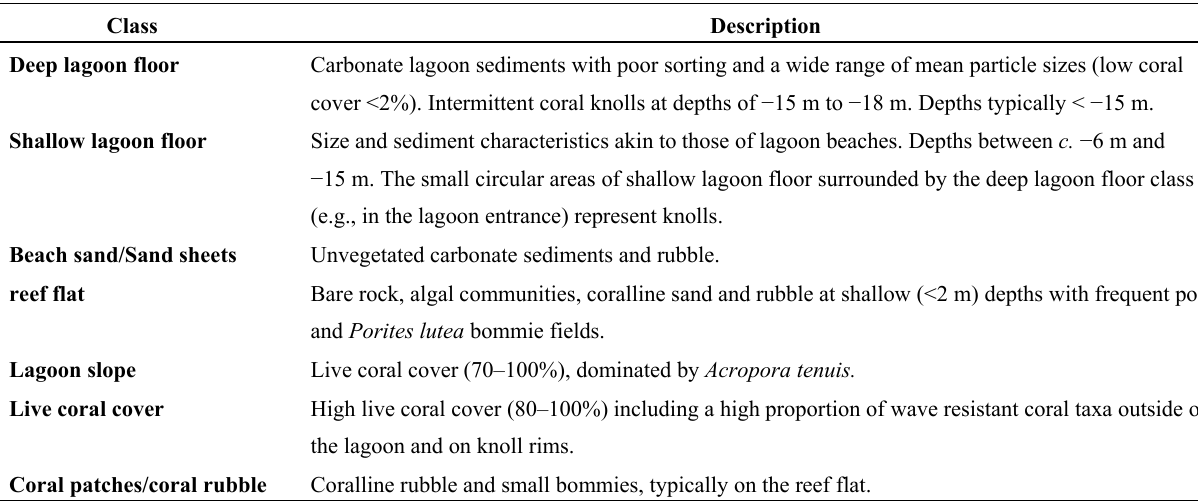
Table 3. Description of each of the benthic cover classes